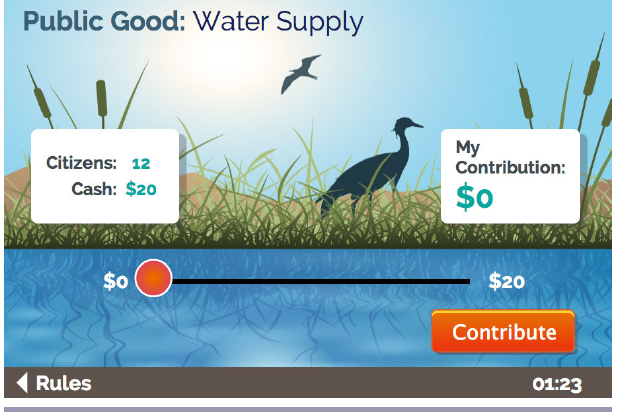
Fig. 10 . A screenshot of the MobLab experimental environment when a public good game is